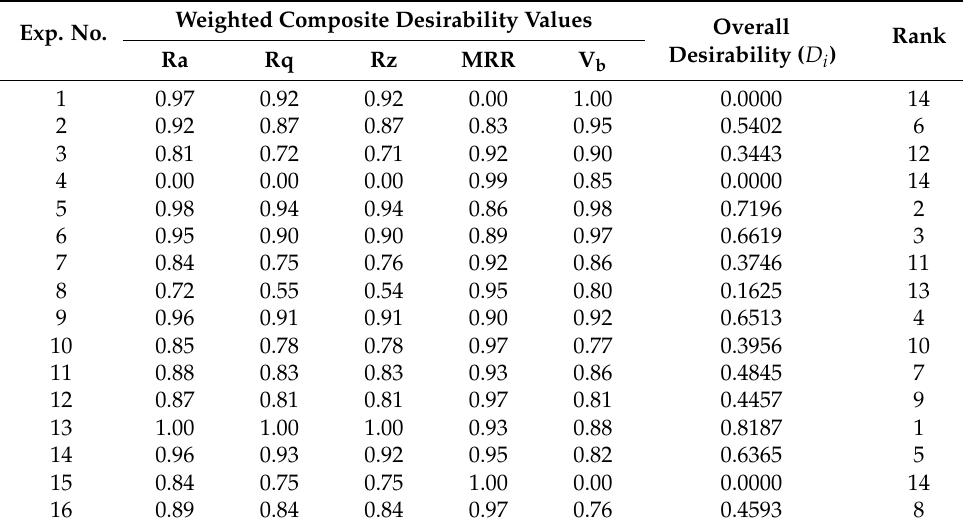
Table 10. Weighted and overall composite desirability.